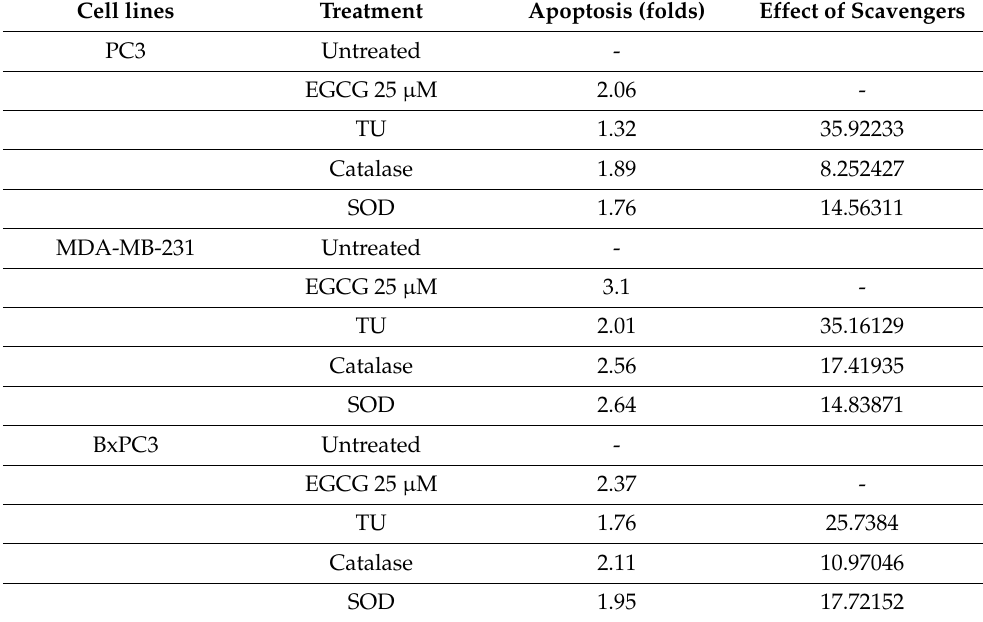
Table 1. Effect of ROS scavengers on EGCG-induced apoptotic activity in three different cancer cell lines. Along with EGCG, cancer cells were incubated with various ROS scavengers, namely TU, 700 µ M Thiourea; Cat, 100 mg/mL catalase; and SOD, 100 mg/mL superoxide dismutase. The effect on apoptosis was assessed by using Histone/DNA ELISA as described in the Materials and Methods section. “Apoptosis (folds)” is the fold increase in apoptosis relative to untreated control. Cell lines Treatment Apoptosis (folds) Effect of Scavengers PC3 Untreated - EGCG 25 µ M